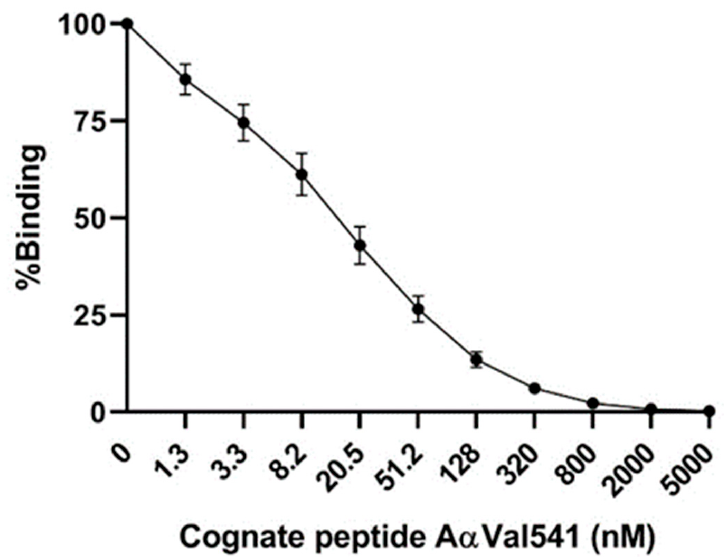
Figure 1. Time-dependent formation of the A α Val541 epitope by PR3 cleavage of fibrinogen. The A α Val541 epitope in fibrinogen was generated by incubating fibrinogen with PR3 for different periods of time. The cleavage reaction was stopped by adding AAT. ( A ) Samples were coated to a 96-well plate and incubated with the A α Val541 antibody, and binding is indicated by fluorescence (see Materials and Methods for details). Three control samples were included. CTRL- 1: preincubation of PR3 with AAT for 30 min before adding fibrinogen. This sample was directly placed on ice after adding fibrinogen. CTRL-2: preincubation of PR3 with AAT for 30 min before the incubation with fibrinogen for one hour. CRLT- 3: incubation of fibrinogen alone for one hour without PR3 or AAT. ( B ) Detection of generation of A α Val541 by Western blot analysis of the different samples of PR3-cleaved fibrinogen obtained at different time points using the A α Val541 antibody. Molecular weight of protein ladder is shown on the left. Lane 1: control, only fibrinogen; Lanes 2–7: incubation of PR3 with fibrinogen for 2 min (lane 2), 5 min (lane 3), 10/15 min (lane 4), 20 min (lane 5), 45 min (lane 6) or 60 min (lane 7); lane 8: control using PR3 preincubated with AAT before addition to fibrinogen and incubation for 60 min. Abbreviations: FL-counts = fluorescence counts.